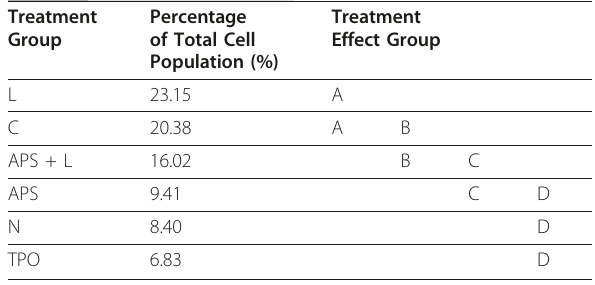
Table 4 Effects of various treatments on the apoptosis of M-07e cells detected by Caspase 3